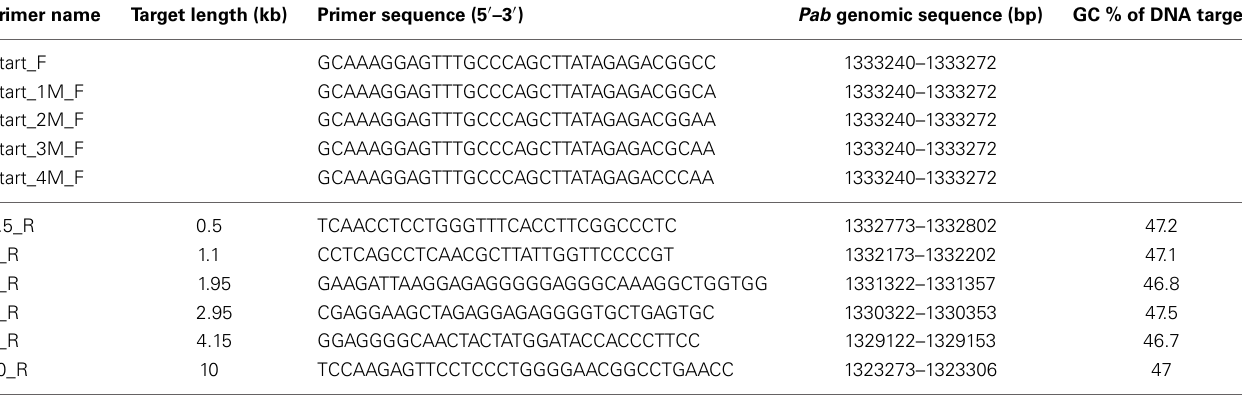
Table 1 | Primers applied in this